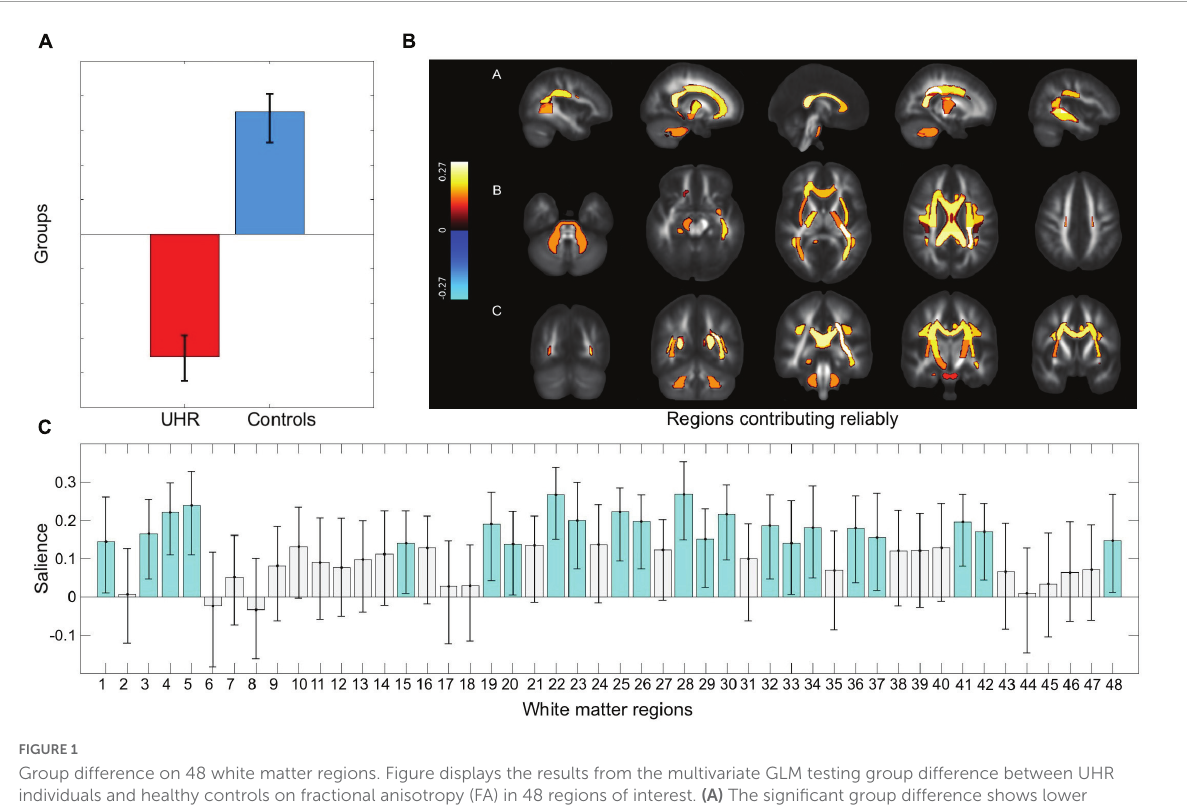
FIGURE1 Group difference on 48 white matter regions. Figure displays the results from the multivariate GLM testing group difference between UHR individuals and healthy controls on fractional anisotropy (FA) in 48 regions of interest. (A) The significant group difference shows lower fractional anisotropy in UHR individuals compared to healthy controls in the 48 regions of interest (ROIs). (B) The ROIs which contributes reliably are visualized using JHU white matter atlas. Reliably contributing regions are bilaterally: middle cerebellar peduncle; genu, body, and splenium of corpus callosum; posterior limb of internal capsule; superior corona radiata; posterior thalamic radiation; external capsule; and superior longitudinal fasciculus. Left hemisphere: retrolenticular part of internal capsule; posterior corona radiata; sagittal stratum; cingulum; and tapetum. Right hemisphere: cerebral peduncle; anterior corona radiata; and cingulum hippocampus. (C) The pattern of covariance in all 48 ROIs, with the regions contributing reliably marked in turquoise. A list linking the numbers to the regions are displayed in the Supplementary Text 3 . A, anterior; L, left; P, posterior; R, right; UHR, ultra-high